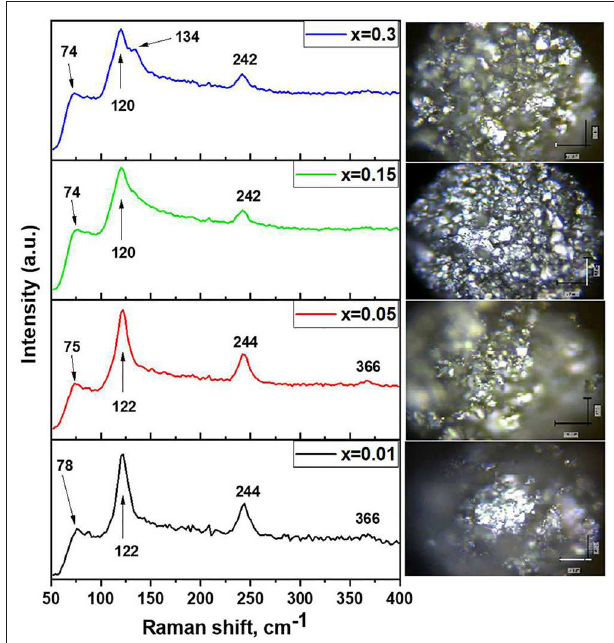
FIGURE 3 | (A) Optical absorption spectra of the samples Cs 2 − x Sn 1 − x In x I 6 − 2 x ( x = 0.01–1.0). (B) Tauc plot for Cs 2 SnI 6 -based compounds, and (C) scheme of the electronic band structure of CsInI 4 .